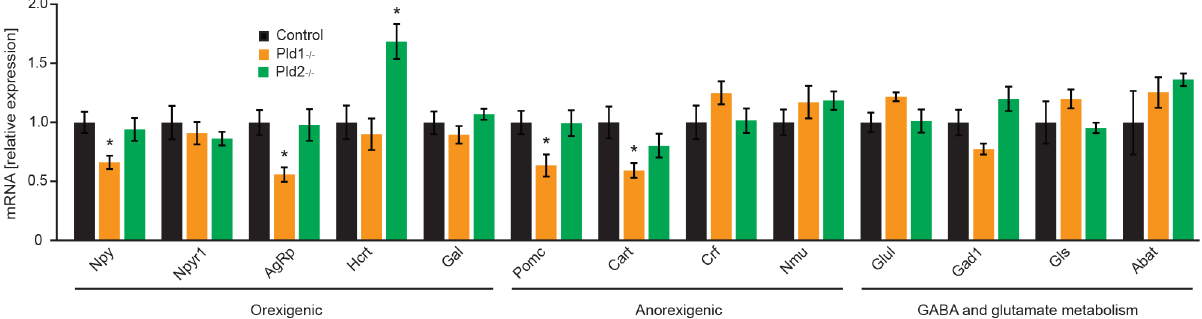
Fig 4. mRNA expression in hypothalamus of neuropeptides controlling food intake. Relative expression of mRNA in hypothalamus of Pld1 -/- , Pld2 -/- and control mice. The analyzed targets are presented as those with known orexigenic effect: neuropeptide Y (Npy), neuropeptide Y receptor 1 (Npyr1), Agouti Related Neuropeptide (AgRp), Hypocretin (Hcrt), Galanin (Gal); those with anorexigenic effect: Pro-opiomelanocortin (Pomc), Cocaine-amphetamine-regulated transcript (Cart), Corticotropin-releasing factor (Crf), Neuromedin U (Nmu); and those involved in the metabolism of GABA and glutamate: Glutamate-ammonia ligase (Glul), Glutamate decarboxylase (Gad1), Glutaminase (Gls) and 4-aminobutyrate aminotransferase (Abat). Data represented as mean +/- S.E.M., n = 6 males for control (black), n = 5 males for Pld1 -/- (orange), n = 6 males for Pld2 -/- (green). * p < 0.05, ** p < 0.01, *** p < 0.001